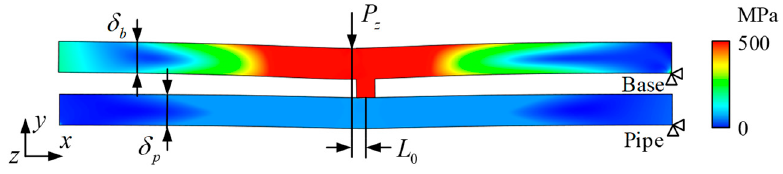
Figure 4. Macroscopic 2D axisymmetric FE model of the assembly.